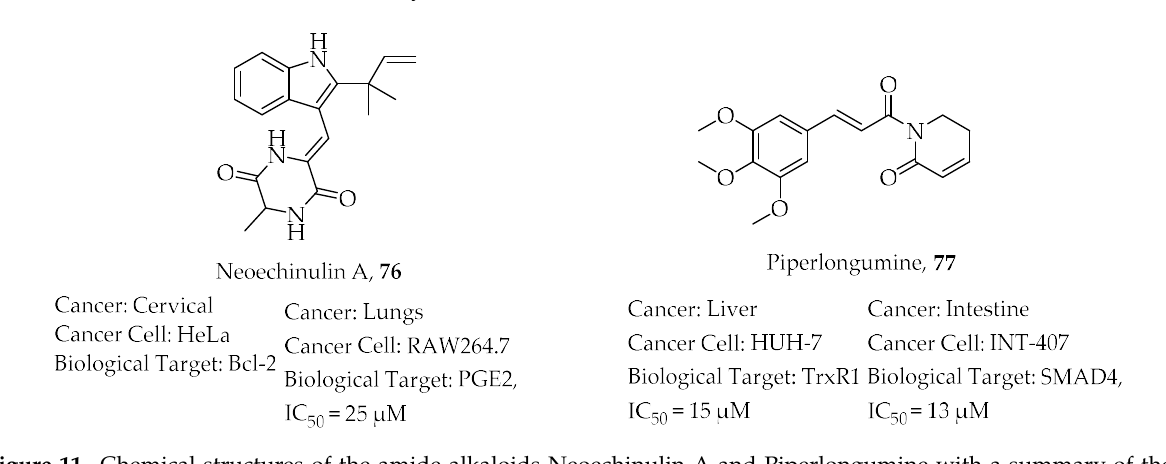
Figure 11. Chemical structures of the amide alkaloids Neoechinulin A and Piperlongumine with a summary of their biological activity towards selected cancer targets.